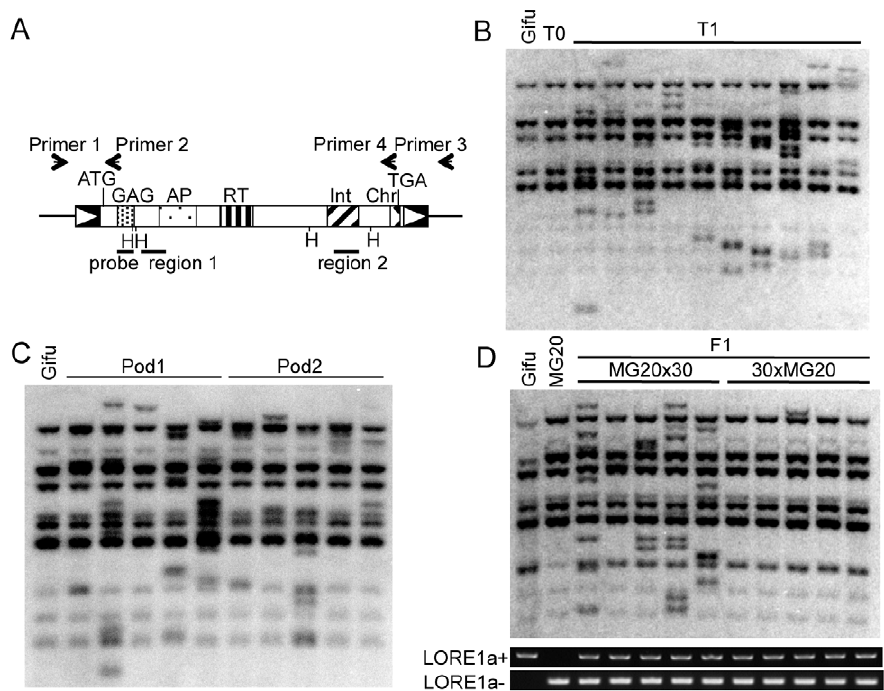
Figure 1. LORE1 transposition. (A) Schematic representation of the LORE1 a element. Boxes with triangles represent long terminal repeats (LTRs). Regions encoding functional domains predicted by Pfam are indicated as patterned boxes. GAG, Retrotransposon gag protein; AP, Aspartic protease; RT, reverse transcriptase; Int, integrase core domain; Chr, chromodomain. Positions of Primers 1, 2, 3, and 4 are indicated with arrows. Regions 1 and 2, containing LORE1 a-specific SNPs, are indicated as bars. Positions of the DNA probes and Hin d III sites used in the genomic Southern blot analyses shown in (B–D) are represented as bars and vertical lines with H, respectively. (B) Southern blot detection of transposed LORE1 elements in T1 siblings. LORE1 copies in control Gifu (Gifu), a T0 individual (T0), and 10 of its T1 siblings (T1) were analyzed. (C) LORE1 transposition in late development. Five siblings originating from each of two pods, pod1 and pod2, set at the top of the same inflorescence of a LORE1 -activated T0 plant. (D) Southern blot analysis showing germline inheritance of LORE1 via male gametophytes. DNA from five F1 plants from each of the MG20 (female) 6 no. 30 (male) and no. 30 (female) 6 MG20 (male) crosses was analyzed. Gel images show PCR products obtained using Primers 1 and 2 detecting LORE1 a ( + LORE1 a) from Gifu, and Primers 1 and 3 detecting absence of LORE1 a ( 2 LORE1 a), the allele from MG20. Amplification of both bands confirmed the hybrid